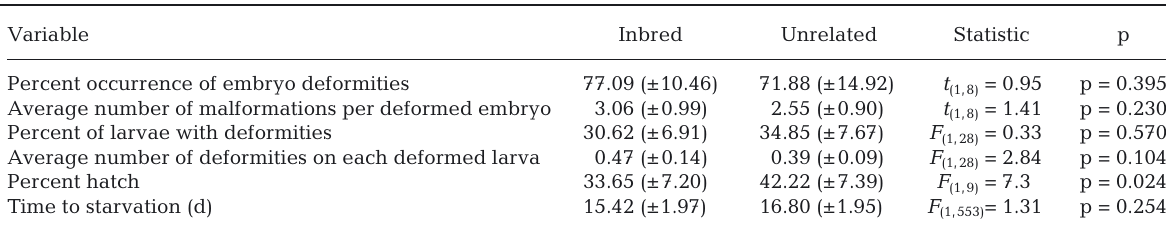
Table 3. Gadus morhua . Full statistics for deformity, hatch, and starvation data collected for Atlantic cod from the in vitro fertilization experiment: mean (±SE; SD for time to starvation) for inbred and unrelated crosses, the t - or F -statistic, and